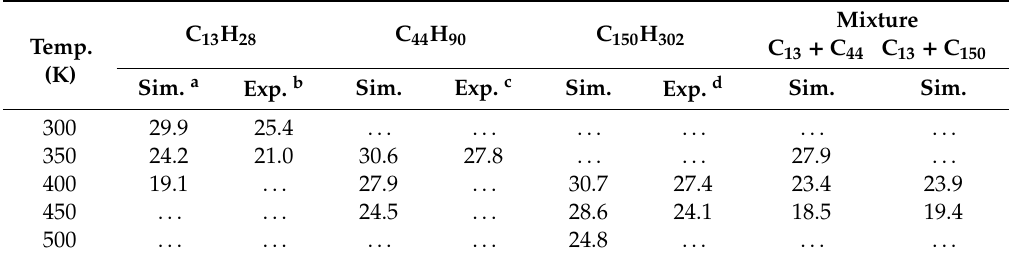
Table 1. The surface tension of polyethylene films obtained from molecular dynamics simulations. The unit is dyn / cm.